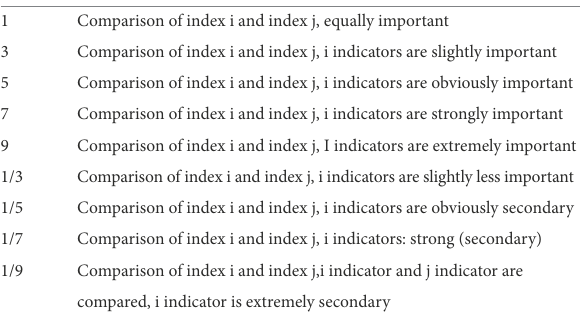
TABLE 2 Grade 9